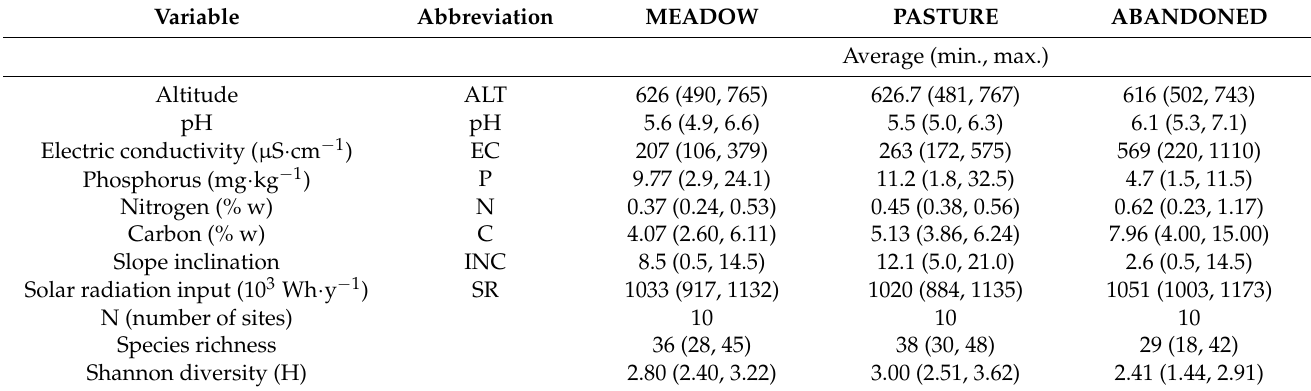
Table 1. Basic characteristics of the studied plots. Average, minimum, and maximum values are shown. Physico-chemical variables refer to soil